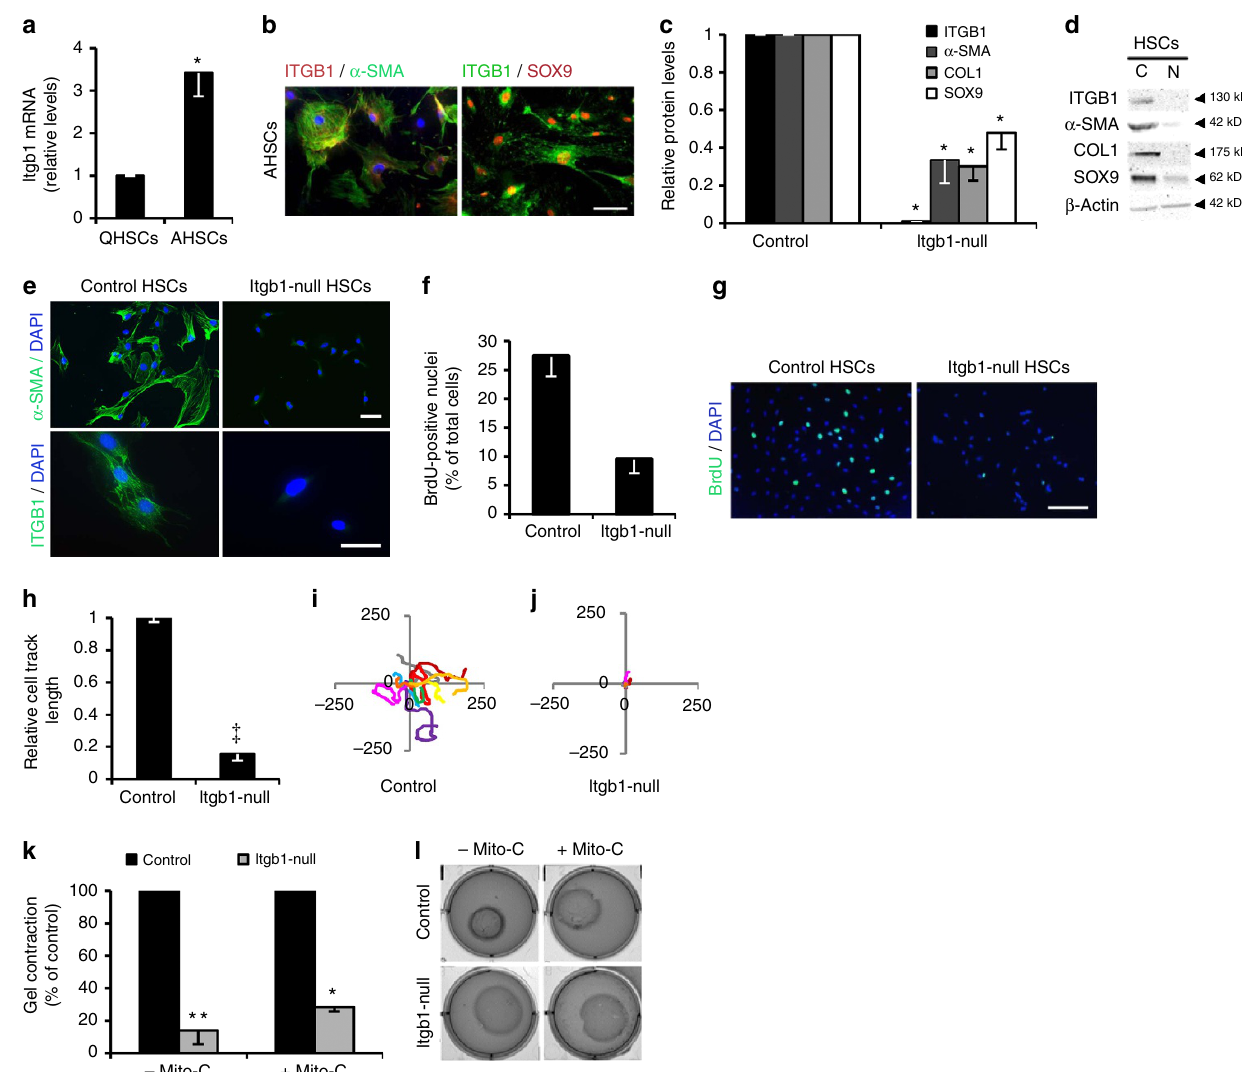
Figure 1 | Integrin beta-1 is increased in activated HSCs and required for phenotype and function. ( a ) integrin beta-1 is increased in activated (A) compared with quiescent (Q) rat HSCs by qRT–PCR. ( b ) Immunofluorescence of rat AHSCs shows integrin beta-1 costained in cells with pro-fibrotic markers a -SMA (green; DAPI as blue nuclear counterstain) and SOX9 (red). ( c , d ) Activated mouse HSCs (‘Control’) show decreased protein levels for a - SMA, COL1 and SOX9 by immunoblotting following the loss of integrin beta-1 (‘ Itgb1 -null’). Quantification from n Z 3 experiments in c and example immunoblots shown in d . ( e ) a -SMA is lost by immunofluorescence from activated mouse HSCs (‘Control’) following integrin beta-1 inactivation (‘ Itgb1 - null’). DAPI (blue) used as nuclear counterstain. ( f , g ) Proliferation measured by BrdU incorporation of activated mouse HSCs (‘Control’) declines following integrin beta-1 inactivation (‘ Itgb1 -null’). Quantification from n Z 3 experiments in f with example immunofluorescence in g . DAPI, blue nuclear counterstain. ( h , j ) Migration of activated mouse HSCs (‘Control’) over 24h is almost entirely attenuated following the loss of integrin beta-1 (‘ Itgb1 -null’). Quantification from n ¼ 3 biological replicates with 30–77 cells in each experiment in h with an individual example of migratory tracks (in m m) shown in i , j . ( k , l ) Contractile properties of activated mouse HSCs (‘Control’) are markedly attenuated after inactivation of integrin beta-1 (‘ Itgb1 -null’). Quantification of gel contraction from n ¼ 3 experiments is shown in k in the presence or absence of mitomycin-C (Mito-C) and example images shown in l . Scale bars, 50 m m. Two-tailed unpaired t -test was used for statistical analysis. Data are shown as means ± s.e.m. * P o 0.05, ** P o 0.01, z P o 0.001. C, control-activated HSCs; N, integrin beta-1-null